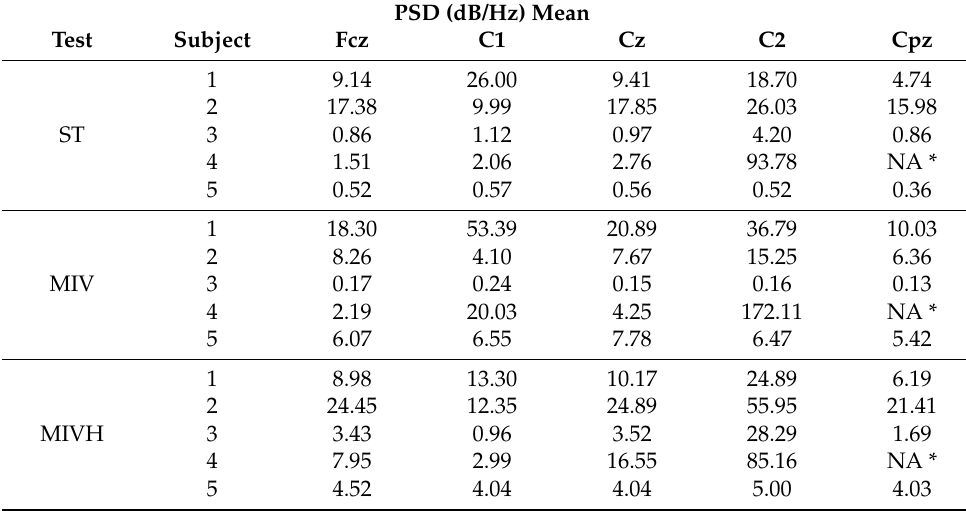
Table 3. Descriptive PSD statistics associated with each patient channel for the ST, MIV, and MIVH test. * Not Applied: The Cpz channel of subject 4 did not have the necessary signal quality to be included in the